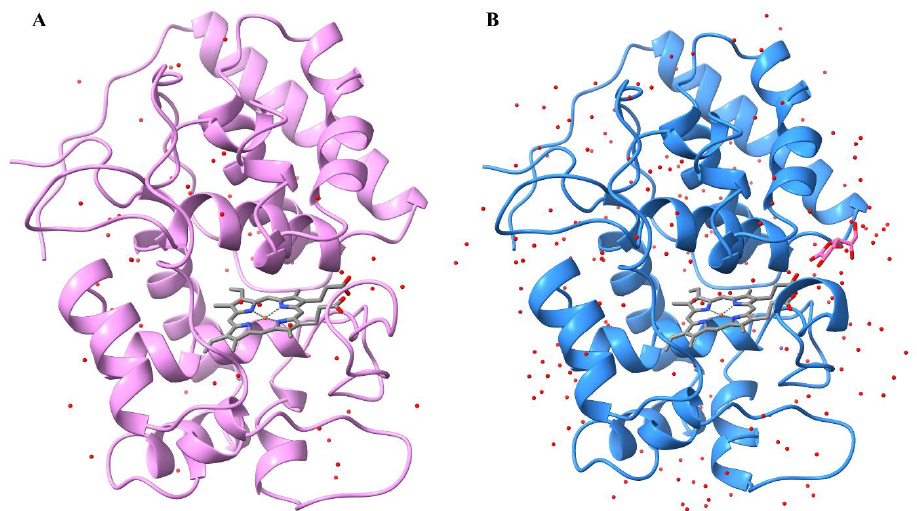
Figure 2. Overall structure of PviAPX. ( A ) PviAPX apo-form structure is shown in pink and heme is shown in gray. ( B ) PviAPX ascorbate complex structure is shown in blue, and ascorbate molecule shown in gray.